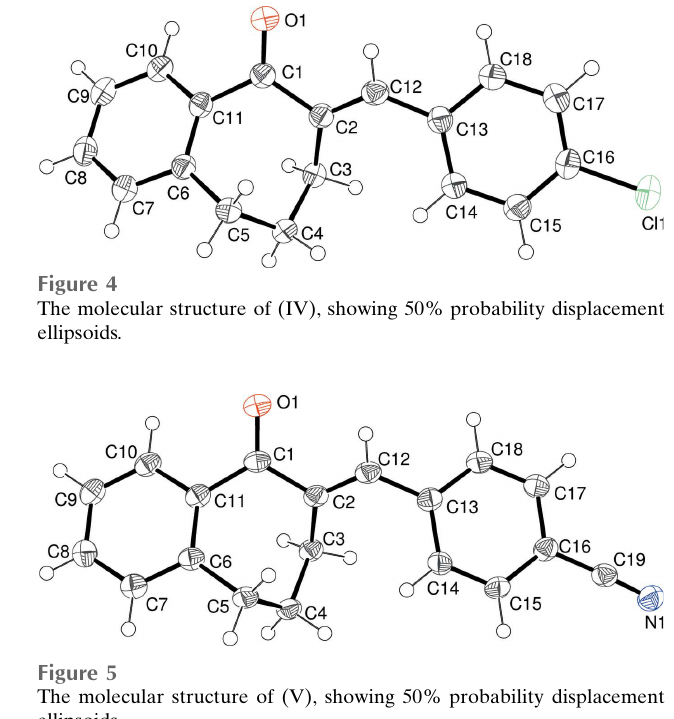
Figure 1 The molecular structure of (I), showing 50% probability displacement ellipsoids.